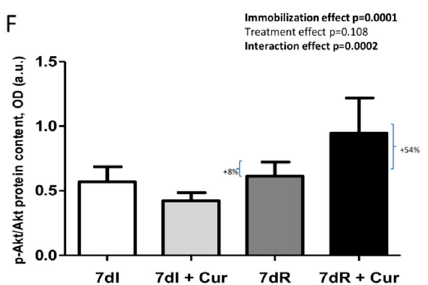
Figure 6. ( A ) Representative immunoblots of MyHC, actin, puromycin-labeled proteins, Akt and phosphorylated Akt proteins in the gastrocnemius muscle of all study groups of mice. Definition of